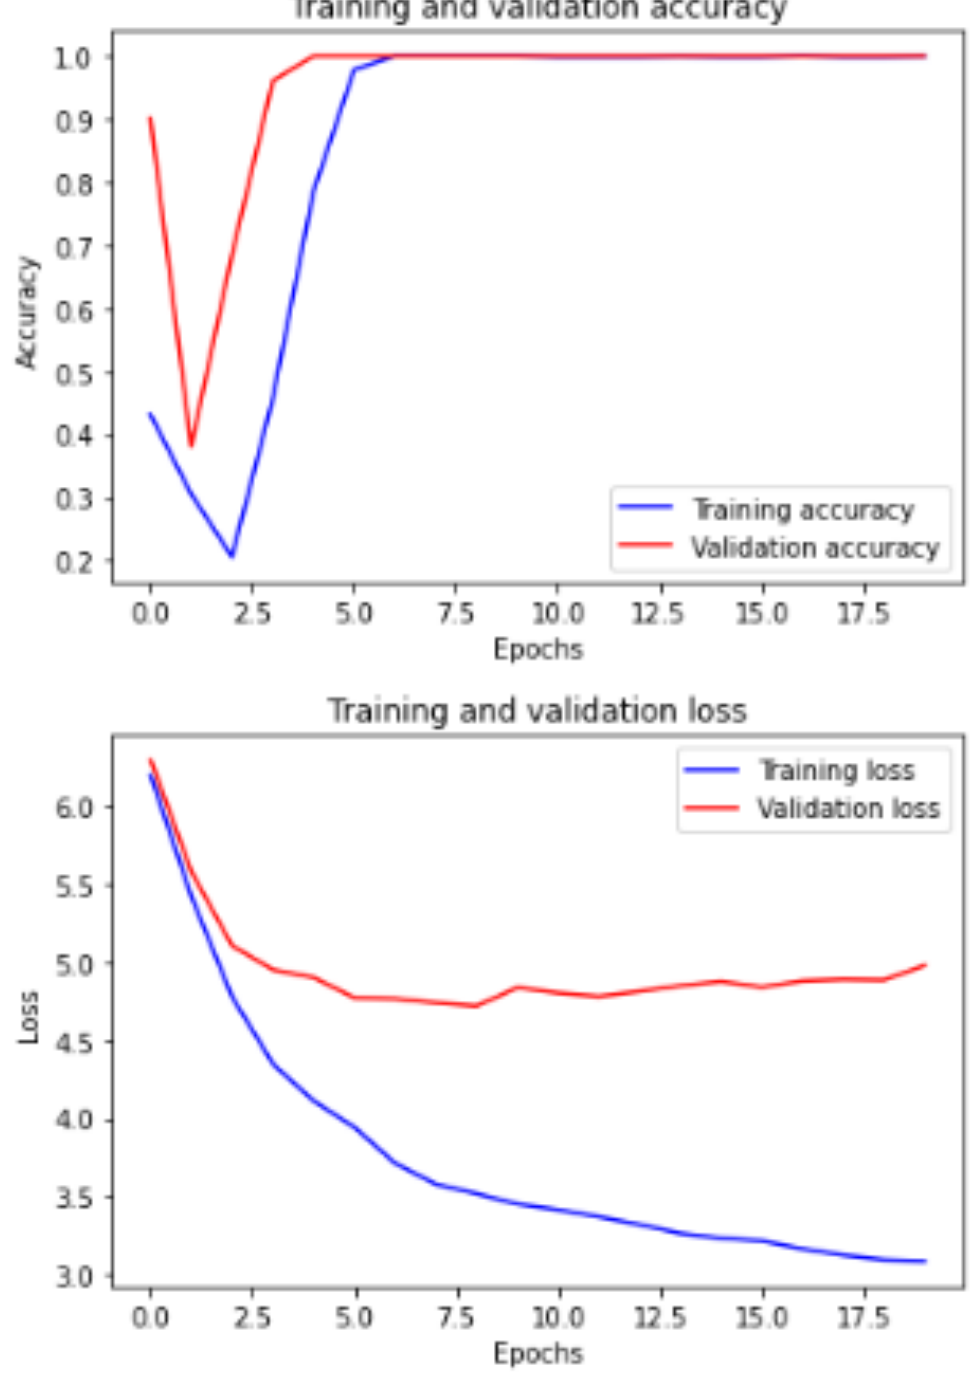
Figure 12. The training and validation ACC and loss through 50 epochs of the mobileNetV2